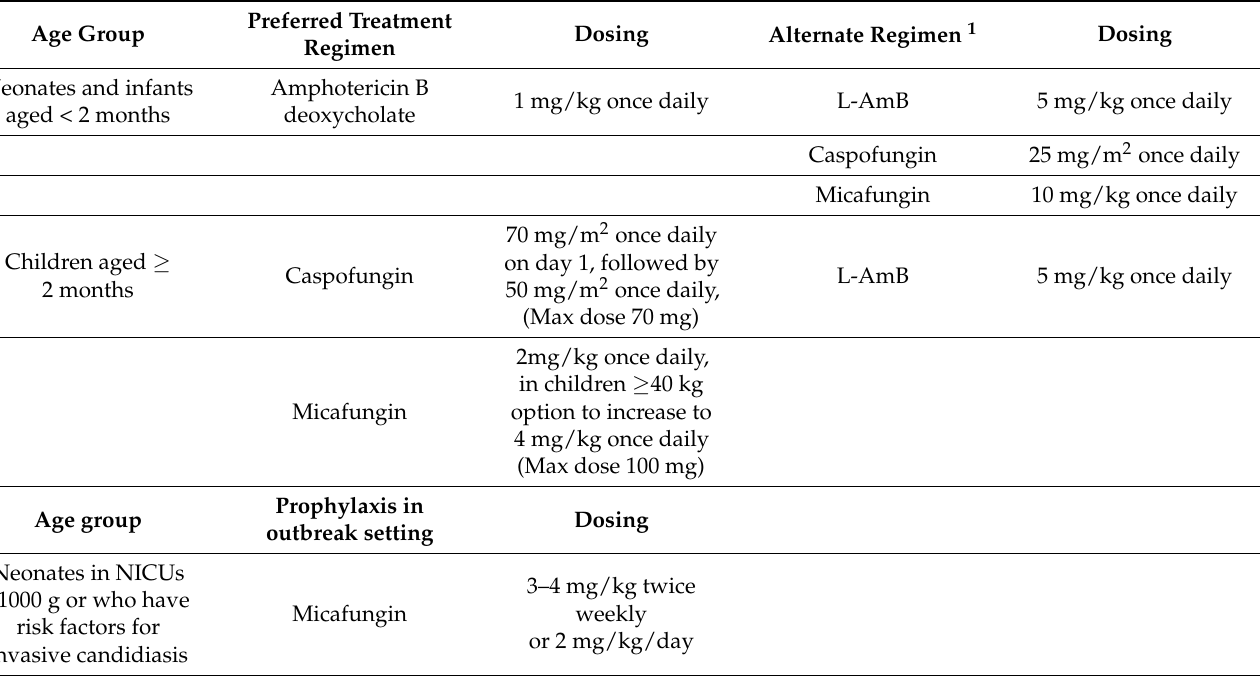
Table 4. Recommended antifungal treatment and prophylaxis for children with C. auris